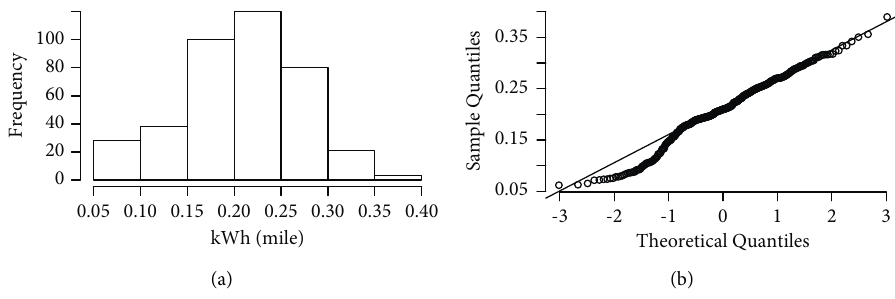
Figure 1: (a) Histogram and (b) Q-Q plot of average energy consumption per mile for the entire sample. Table 5: Descriptive statistics of consumption data per mile by road